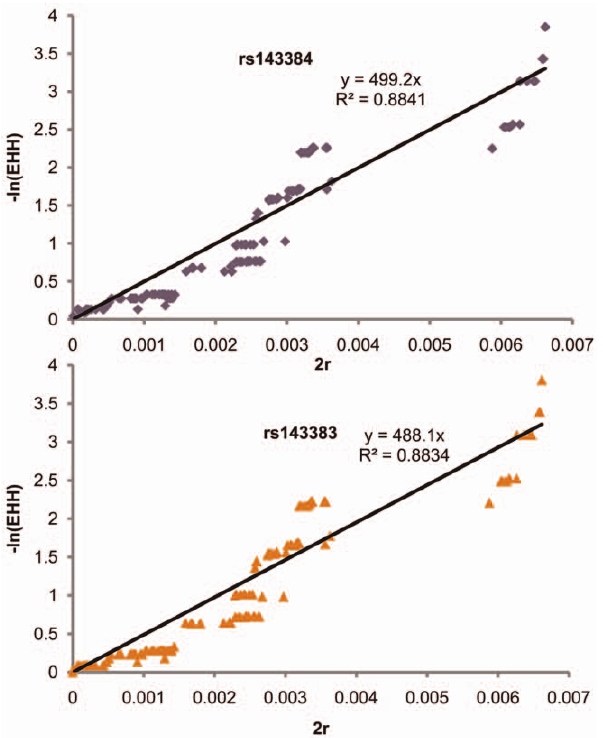
Figure 7. Evaluation of the ages of the derived alleles of SNPs rs143383 and rs143384 by linear regression of 2 ln(EHH) and 2r.